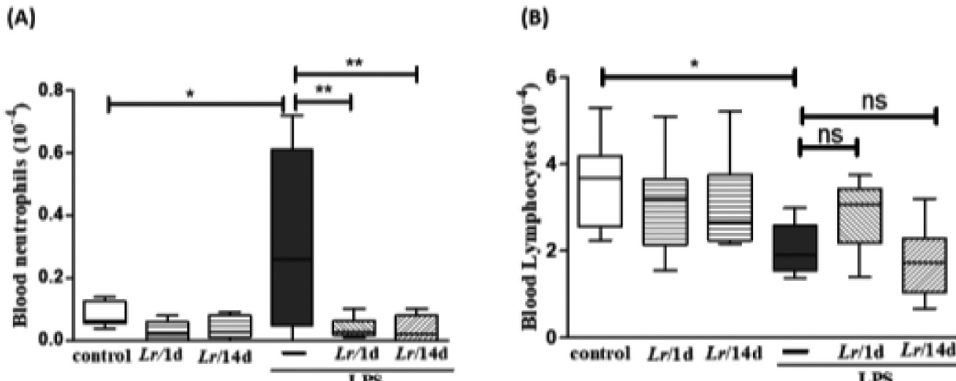
Fig. 3. Leukocytes in blood. The C57Bl/6 mice were treated with Lacticaseibacillus rhamnosus (10 9 CFU of Lr in 300 µ L of PBS, gastric oro by gavage) for 14 days or one day, before the instillation of E. coli LPS (0.5 mg/Kg, intranasal). The mice were euthanized 24 h after the LPS and the whole blood analysis (white and red) was per- formed in according to Materials and Methods. Neutrophil in blood (3A) and Lymphocytes in blood (3B). The results are expressed as mean ± SEM **** p < 0.0001; *** p < 0.001; ** p < 0.01; * p < 0.05 and ns, non-signi fi cant difference.